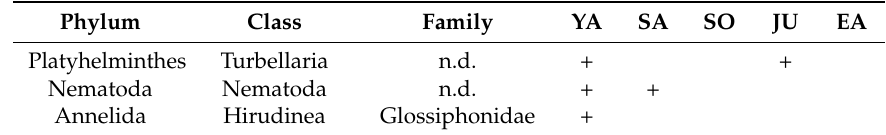
Table 2. Taxa composition of macroinvertebrate assemblages in the five river basins (“+” indicates occurrence of the corresponding